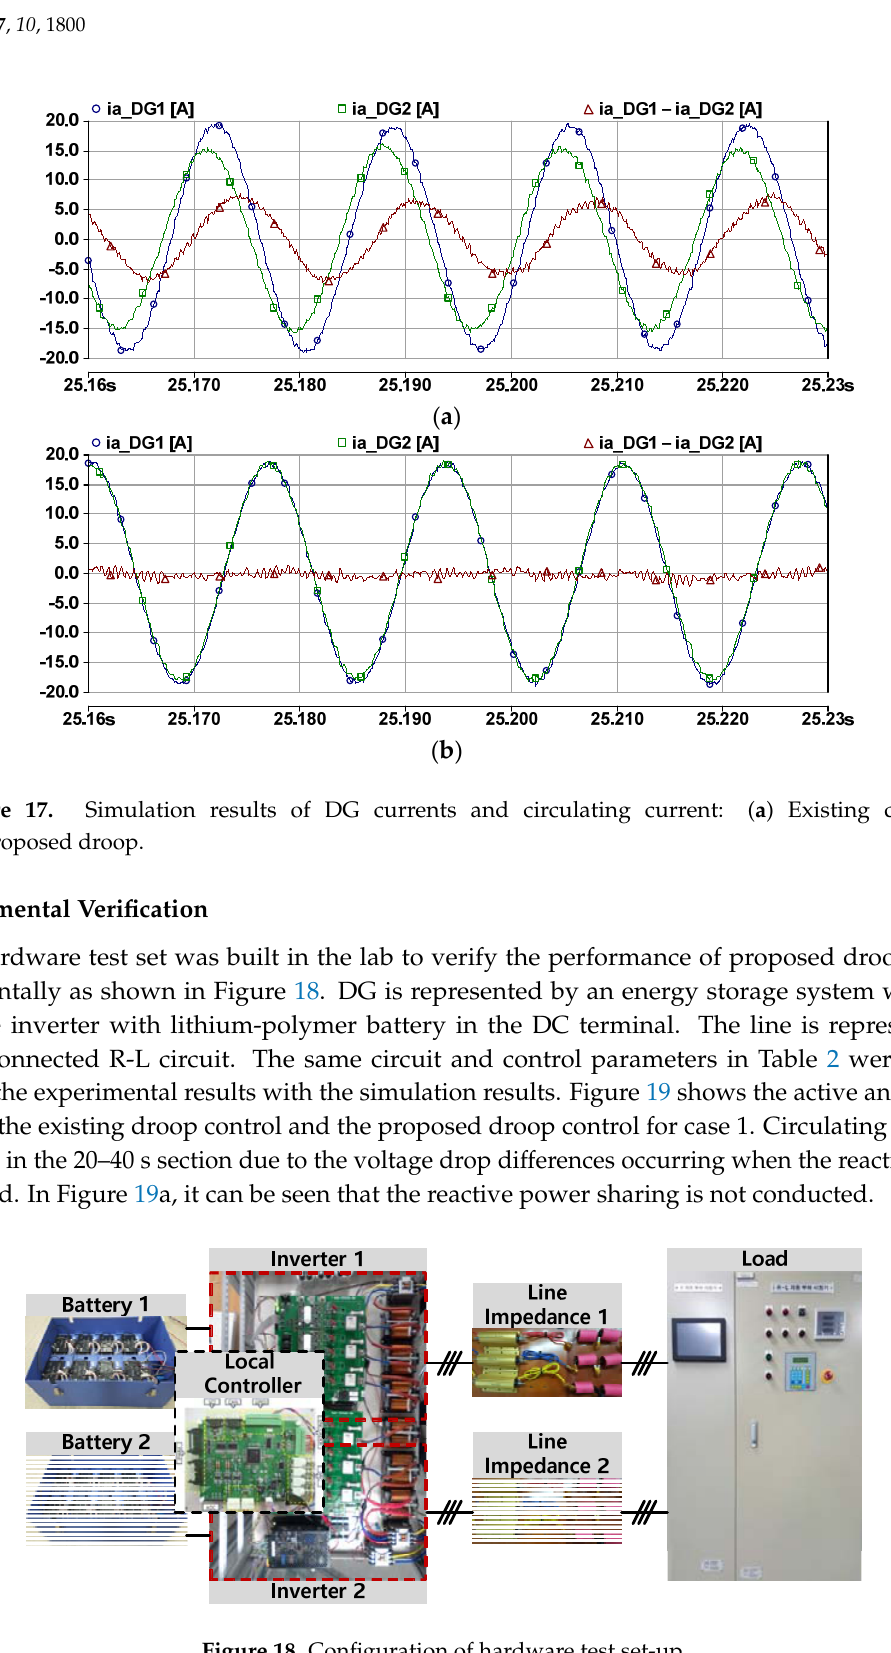
Figure 18. Configuration of hardware test set ‐ up.